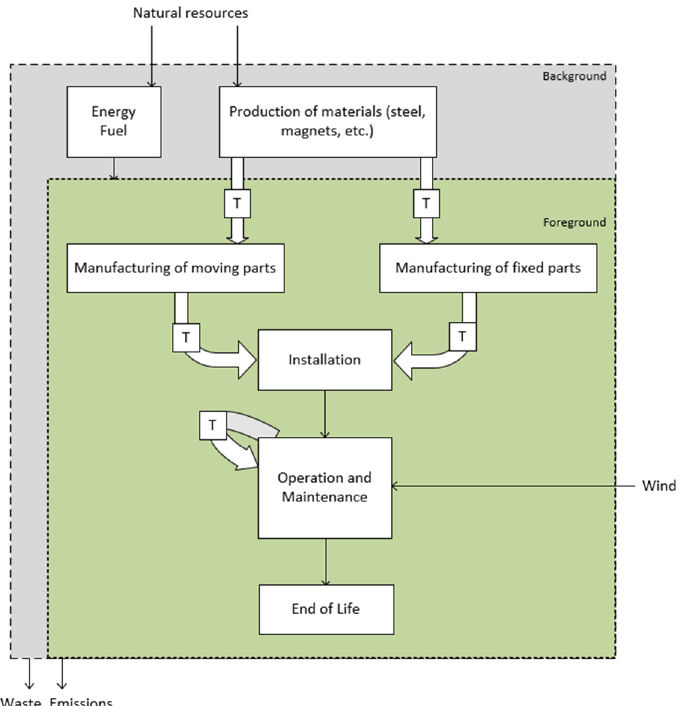
Figure 4. Flowchart of a small wind turbine’s life cycle stages: Foreground processes are depicted in green colour, and background processes in grey colour. T represents transportations. Reprint with permission [47].